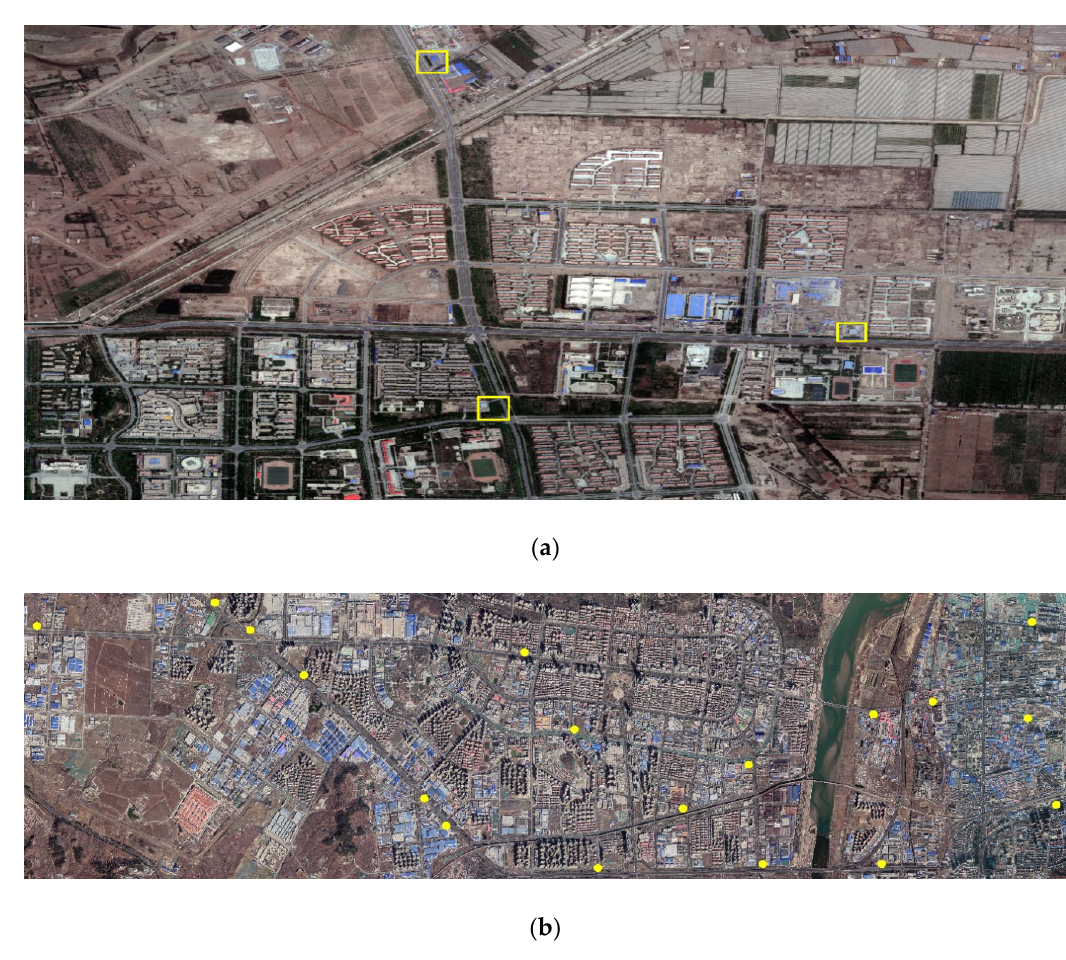
Figure 3. The images to be tested and the ground truth of gas stations. ( a ) WorldView data to be tested and ( b ) Google map data to be tested. Yellow squares and yellow points represent the ground truth of gas stations.